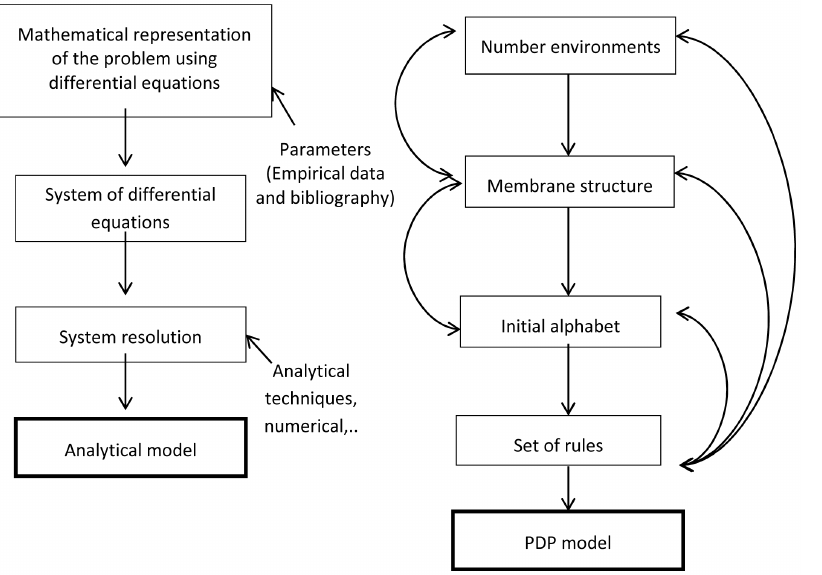
Figure 2. Conceptual representation of the main difference between classical model based on differential equations and PDP models.